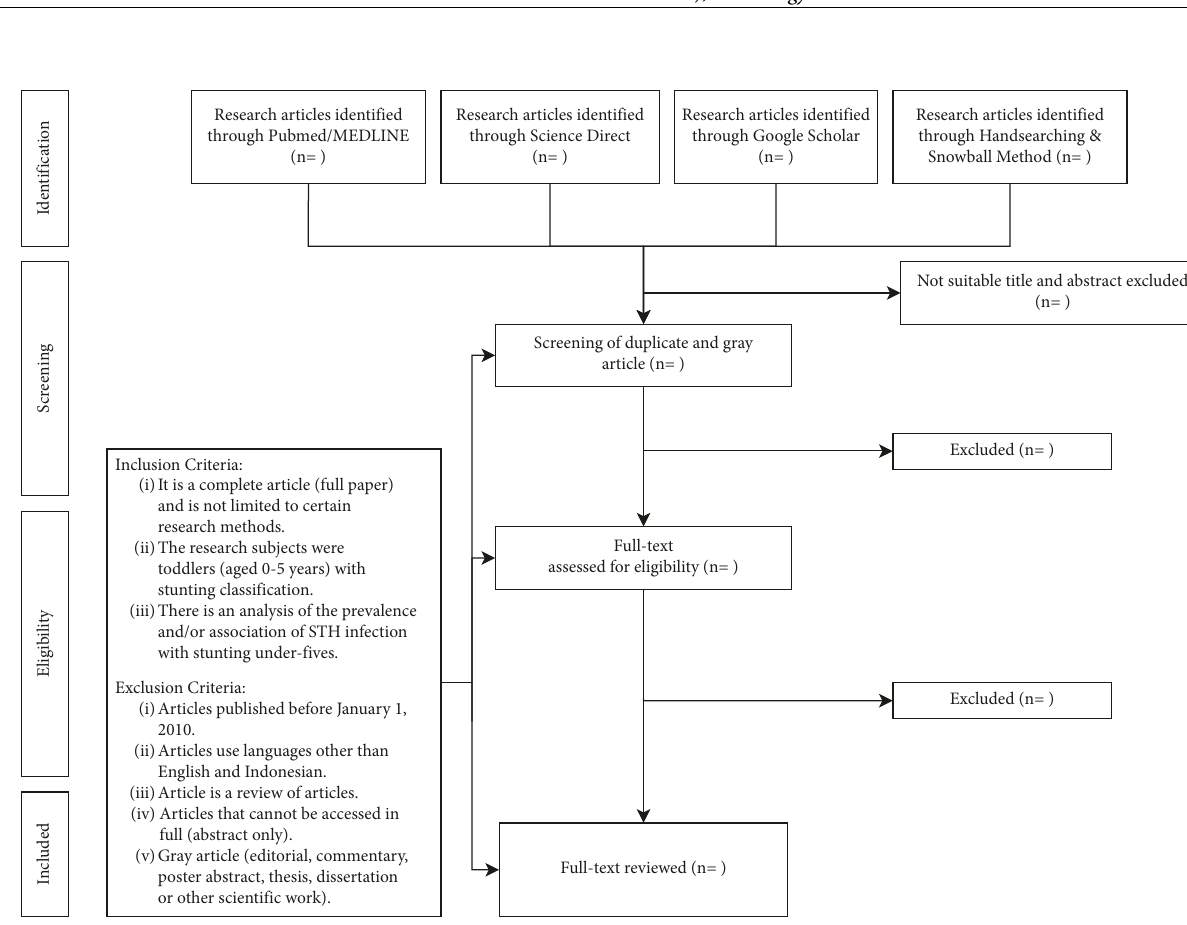
Figure 1: Literature review strategy.